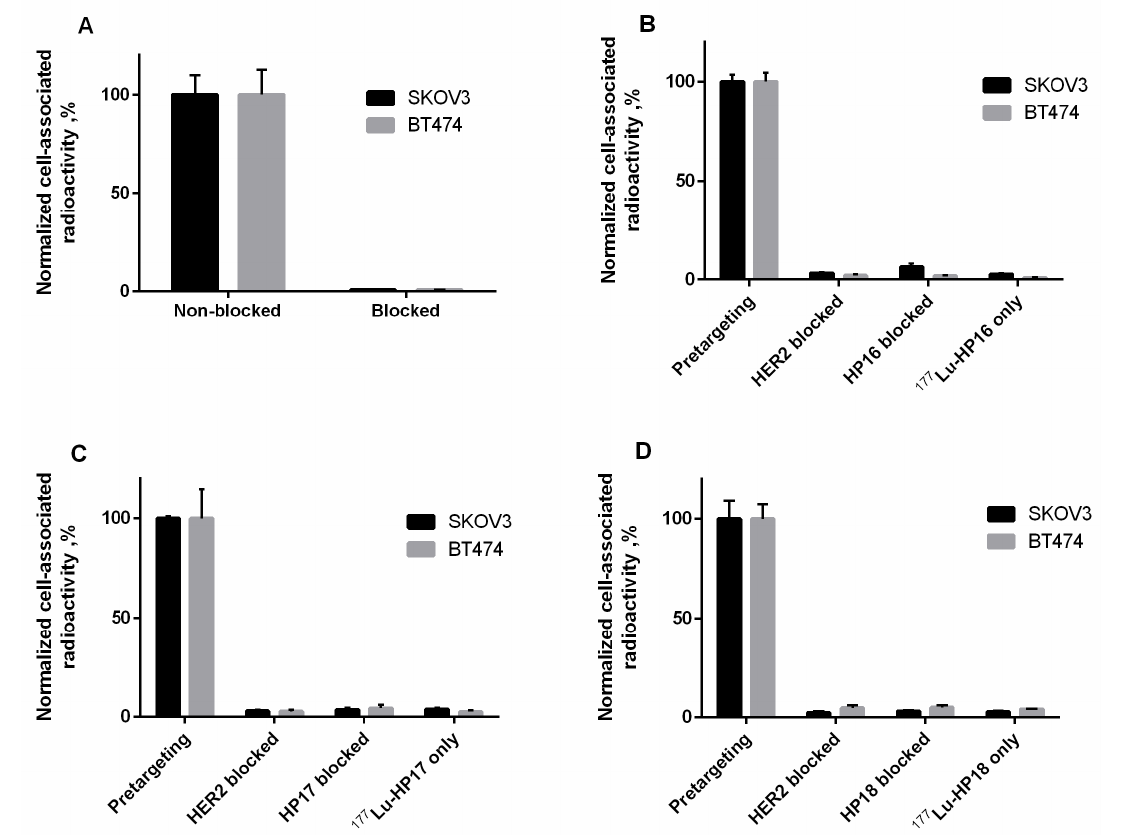
Figure 5. ( A ) In vitro binding specificity of the primary agent [ 177 Lu]Lu-Z HER2:342 -SR- HP15 , ( B ) [ 177 Lu]Lu- HP16 , ( C ) [ 177 Lu]Lu- HP17 , and ( D ) [ 177 Lu]Lu- HP18 on SKOV3 and BT474. The data are presented as an average value from 3 samples ± SD.